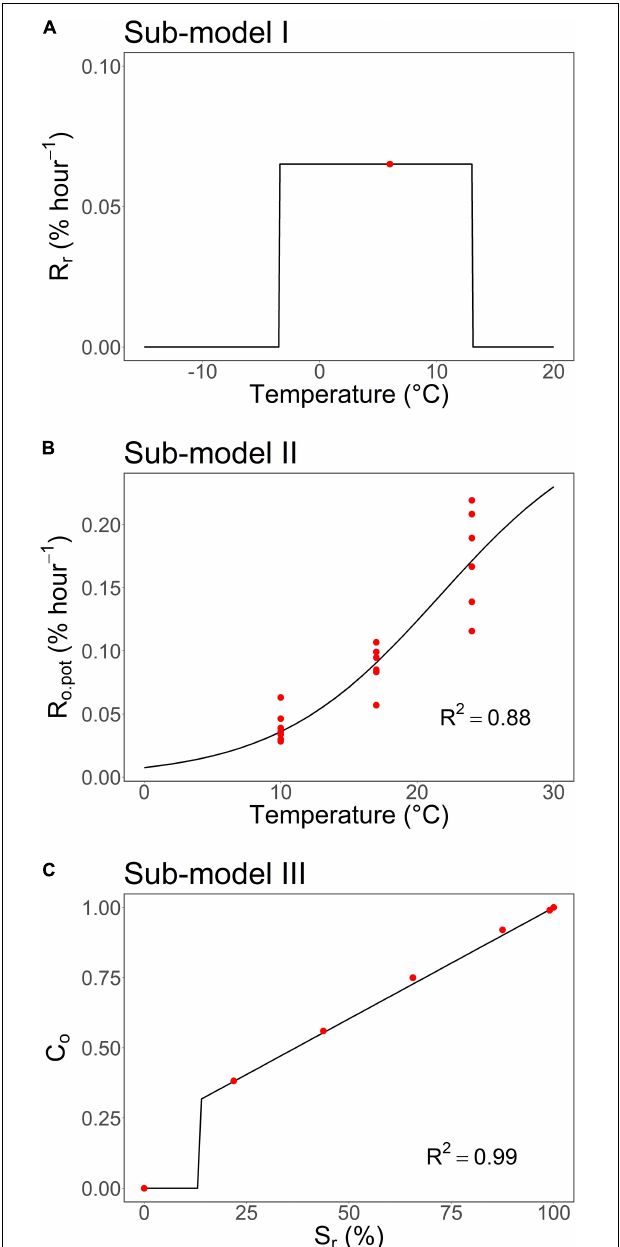
FIGURE 3 | The three sub-models constitute the process-based leaf-out phenology model developed in this study for first-year pecan seedlings. (A) Sub-model I: air temperature response of the rate of a rest break, R r , (Equation 6). (B) Sub-model II: air temperature response of the potential rate of ontogenetic development, R o , pot , (Equation 8). (C) Sub-model III: dependence of ontogenetic competence, C o , on the state of rest break, S r , (Equation 10). For the structure of the overall model and the relationships between the sub-models, refer to Supplementary Figure 1 . The red dots represent the empirical data points calculated based on results from the autumn and spring experiments ( Figures 1 , 2 ) and the black lines and curves the response functions fitted to the data points. For the equations and details of constructing the models, refer to “Constructing the sub-models on the basis of experimental data” in the section “Materials and Methods.” The parameter values of the models can be found in Table 2 .